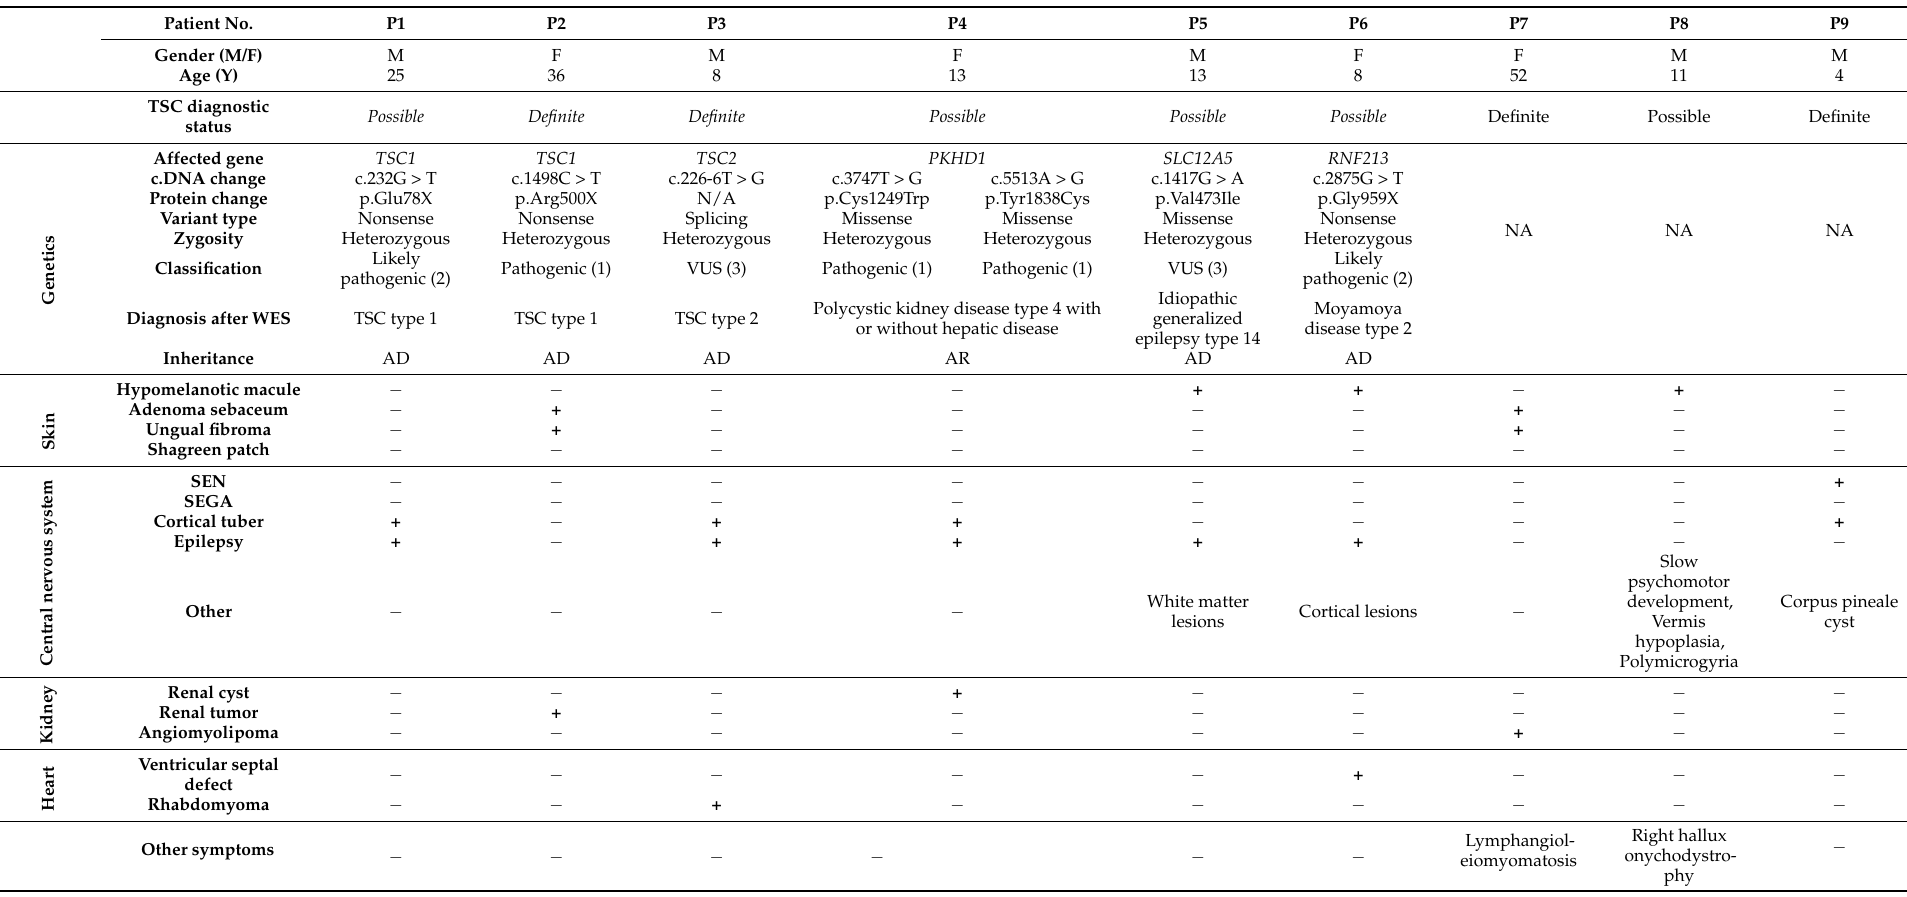
Table 1. Genotype-phenotype features of TSC NMI